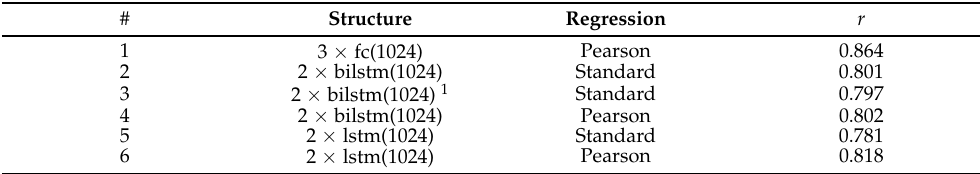
Table 3. Results of various neural network architectures for waveform regression. Row 1 corresponds to the final model chosen.